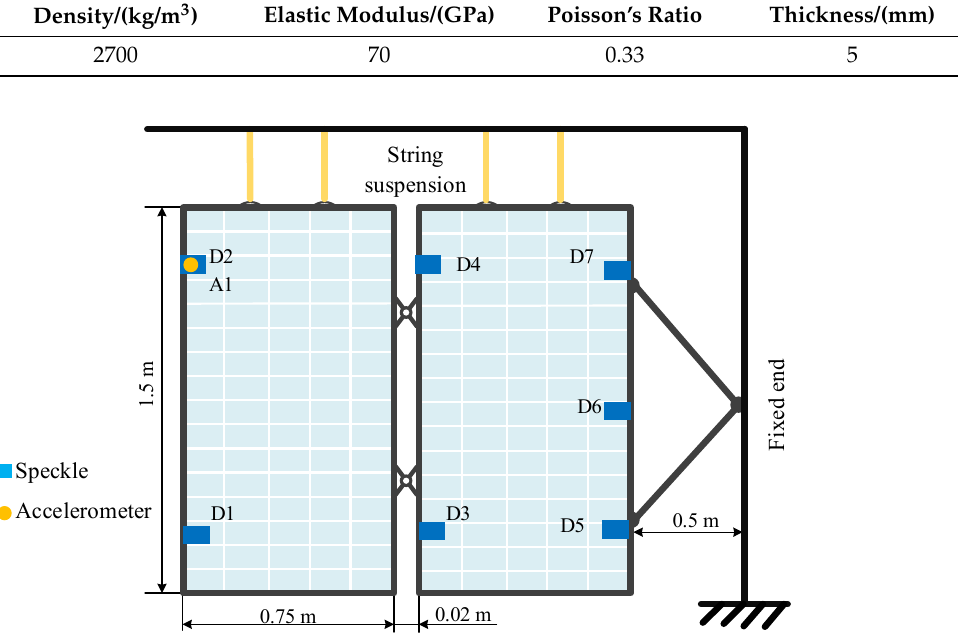
Table 1. Solar wing material properties.